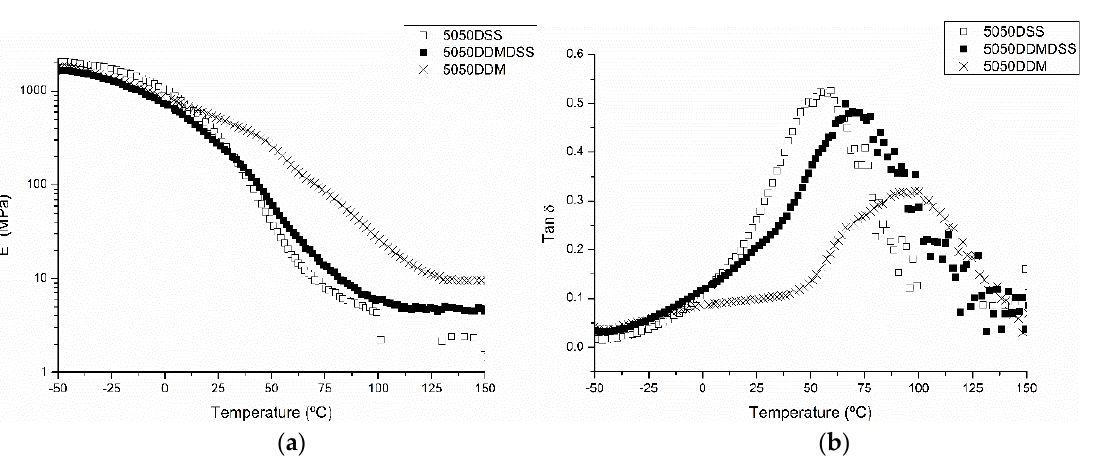
Figure 8. Modulus ( a ) and Tan δ ( b ) vs. temperature for sample 50/50DGEBA/PCL cured with different DDM/DSS ratios.